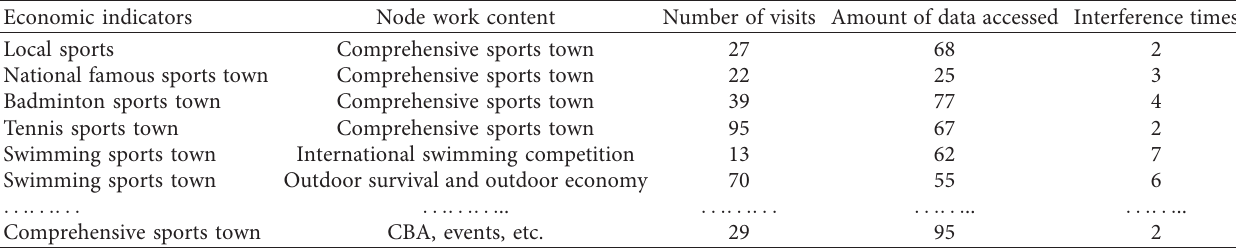
Table 2: The visit to characteristic towns.